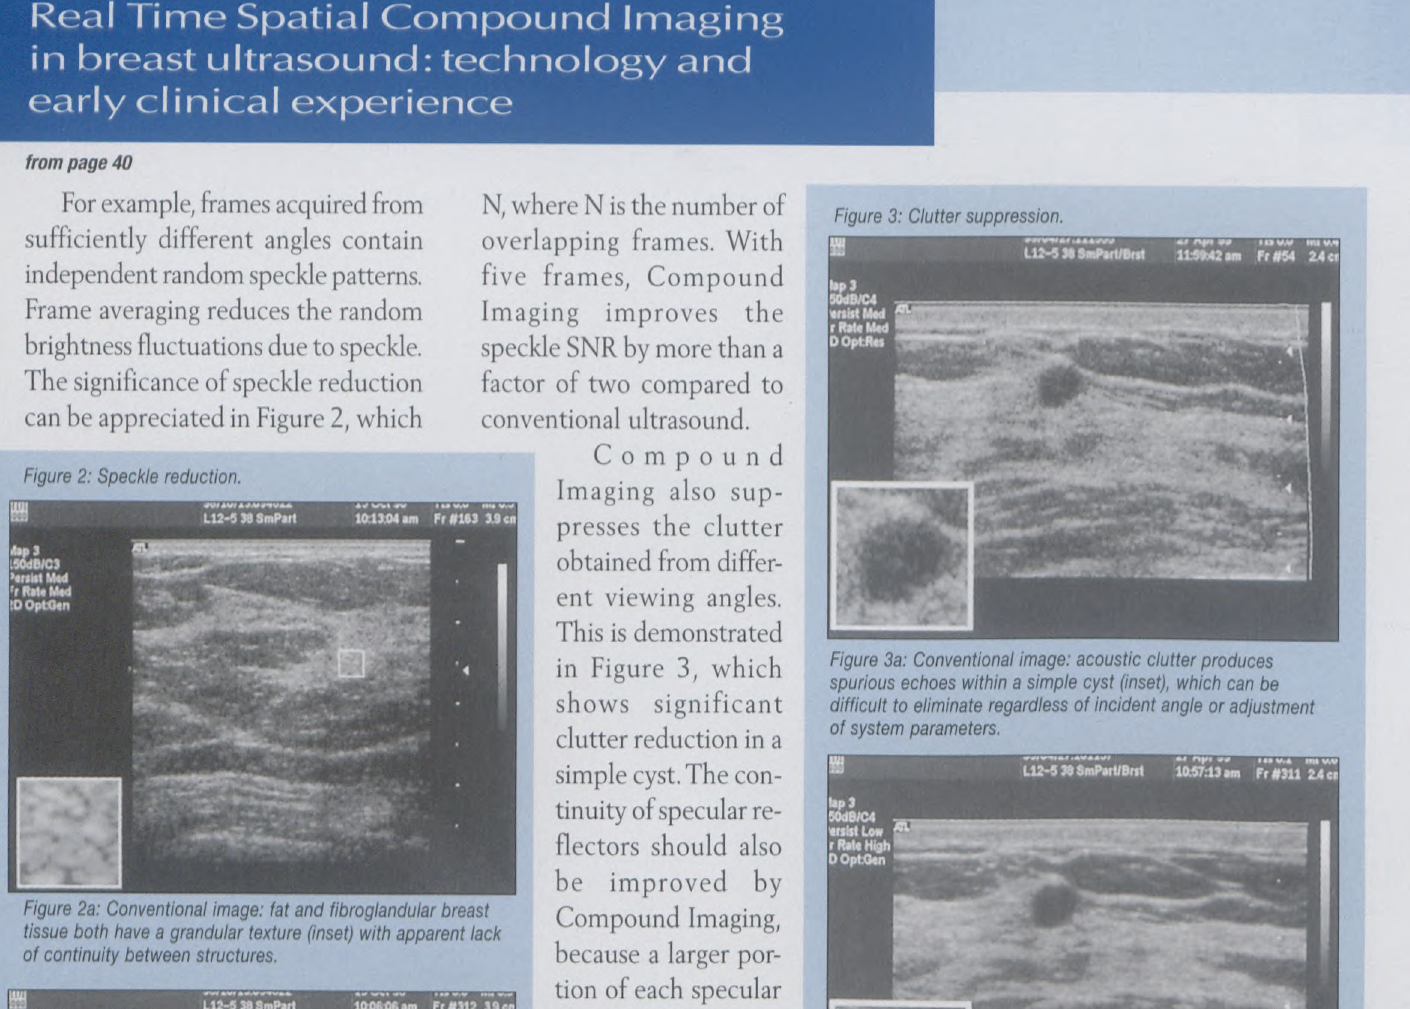
Figure 2a: Conventional image: fat and fibroglandular breast tissue both have a grandular texture (inset) with apparent lack of continuity between structures.